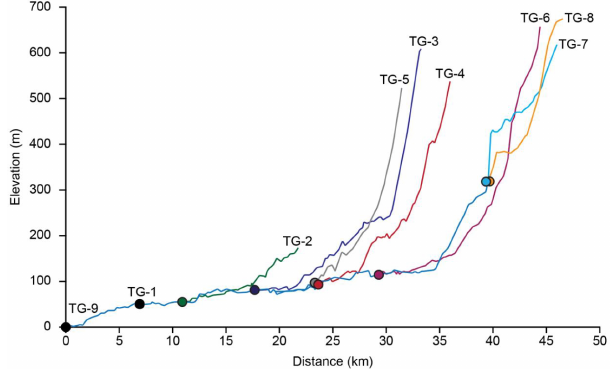
Figure 5. Stream profiles of sampled sites along the George River trunk channel (TG-1, TG-9) and its tributaries (TG-2 through TG-